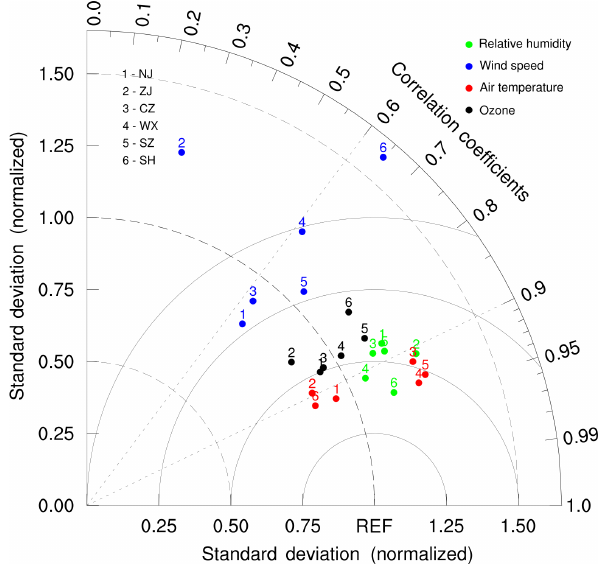
Figure 3. Modeling validations in Taylor plots displaying the stan- dard deviations and correlation coefficients of the simulated and ob- served meteorological elements and surface O 3 concentrations at the six YRD sites (Fig. 1). The azimuthal angle represents the cor- relation coefficient, the radial distance denotes the ratio of standard deviation between simulations and observations, and the semicircles centered at the “REF” marker represents the normalized root-mean- square (NRMS) error (Taylor,